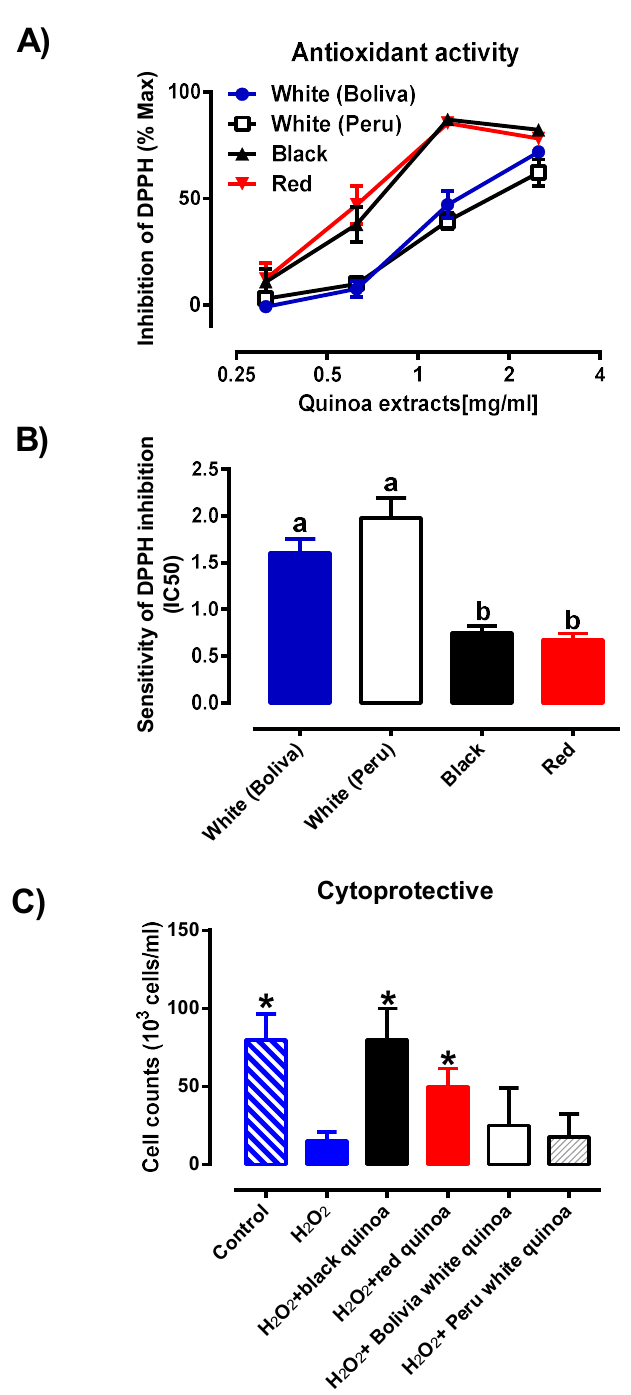
Figure 5. ( A ) Percentage of inhibition of pulverised quinoa seeds from the black, red and white pulverised seed extracts (Bolivia and Peru) were investigated ( n = 6), where each result is represented by mean ± SD with the significance of p ≤ 0.05. ( B ) Sensitivity of DPPH assay of pulverised quinoa seeds from the black, red and white pulverised seed extracts (Bolivia and Peru) were investigated ( n = 6), where each result is expressed as mean ± SD. Di ff erent letters (a, b) represents significantly di ff erent ( p ≤ 0.05) from one another ( C ) Protective e ff ects of extracts from quinoas on H 2 O 2 -induced cytotoxicity on the HMEC-1 cell line. HMEC-1 cells were administered with treatment medium over a period of 48 h. Cell viability was determined by cell counting ( n = 4) before expressing as a cell concentration (cells / mL). Each value represents mean ± SD with the significance accepted at p ≤ 0.05. * Significantly di ff erent between cells treated with H 2 O 2 alone (one-way ANOVA, Tukey’s